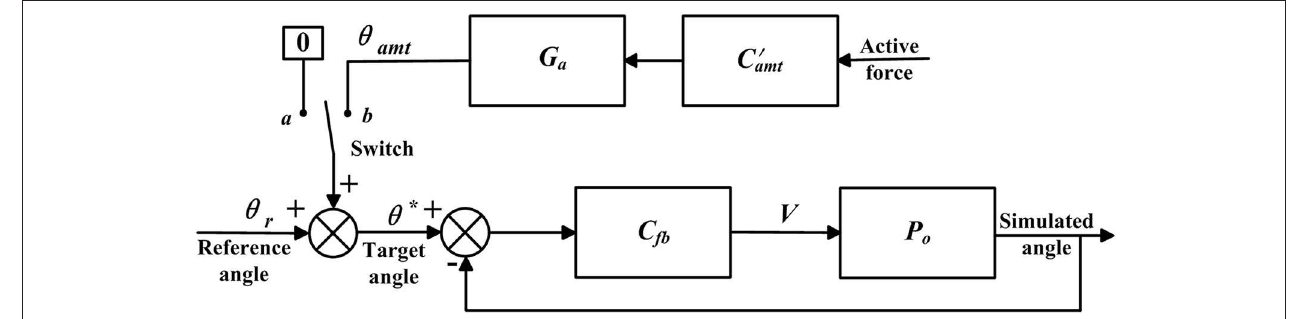
FIGURE 5 | Simulation